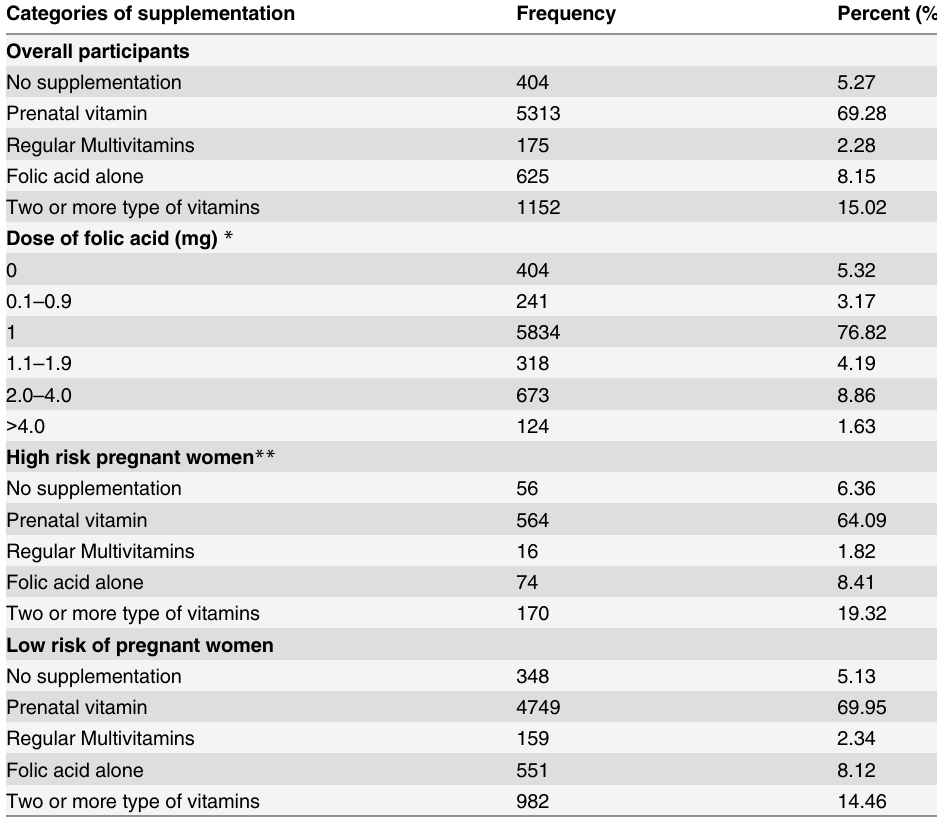
Table 1. Patterns of folic acid